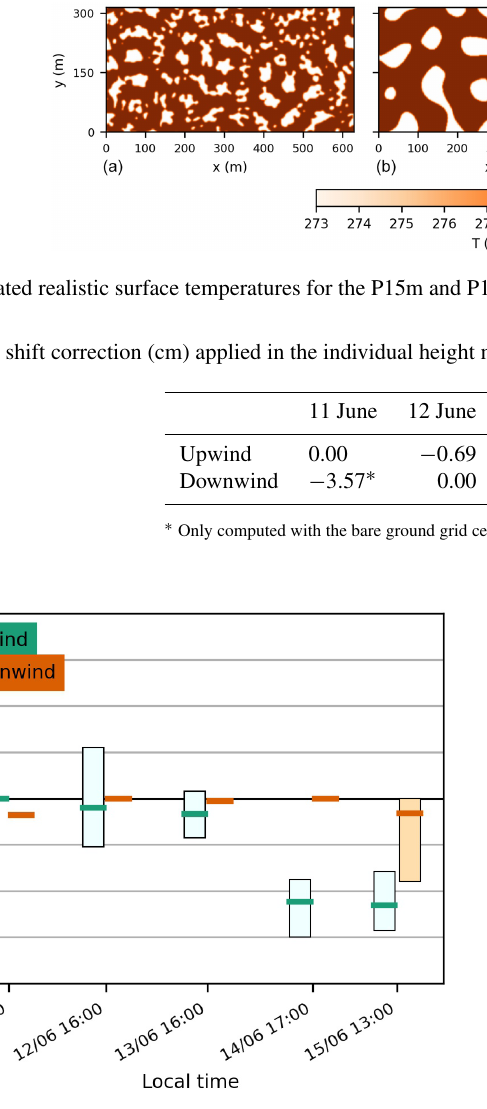
Figure 4. Boxplot of height changes for the upwind and downwind edges of a snow patch recorded with SfM photogrammetry from 11 June 2019 until 15 June 2019. For the upwind edge, 11 June is taken as the reference date. For the downwind edge, the first mea- surement on 11 June is not used as the reference, due to a low cov- erage of grid cells. The melt is estimated with an error of ± 2 . 0 and ± 0 . 4cm, respectively, for the upwind and downwind